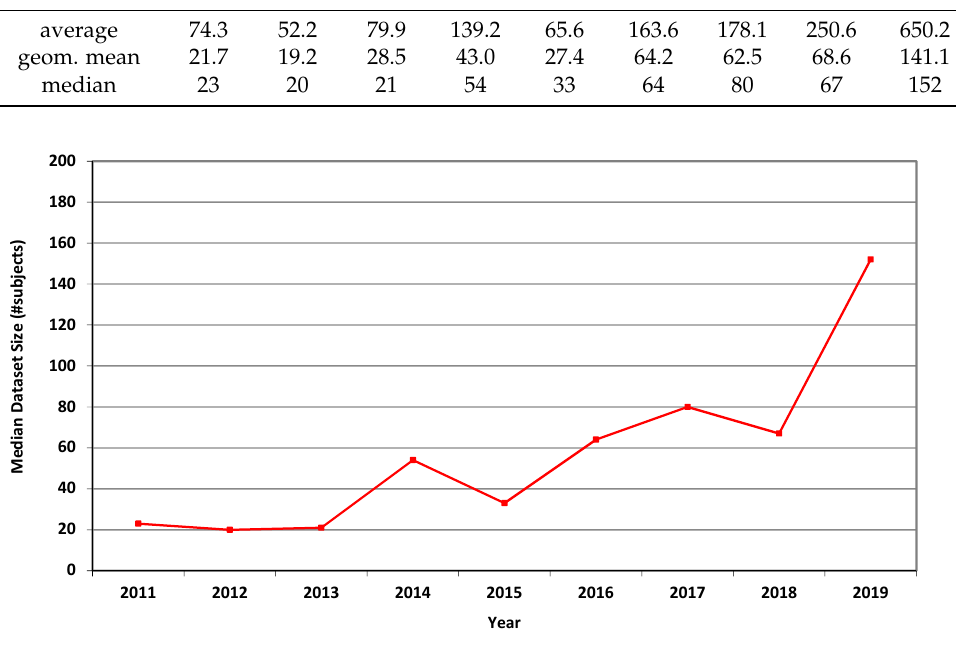
Figure 1. Median size of datasets used in MICCAI articles related to MRI in each of the years 2011–2019. Table 4. Average, geometric mean and median CT dataset sizes (number of subjects) used in MICCAI articles in each of the years 2011–2019.